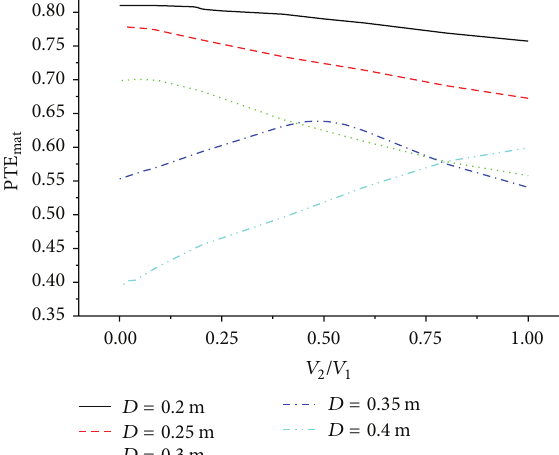
Figure 16: Efficiency of voltage ratio adjusting system at frequency shown in Figure 15 against voltage ratio for different 𝐷 .